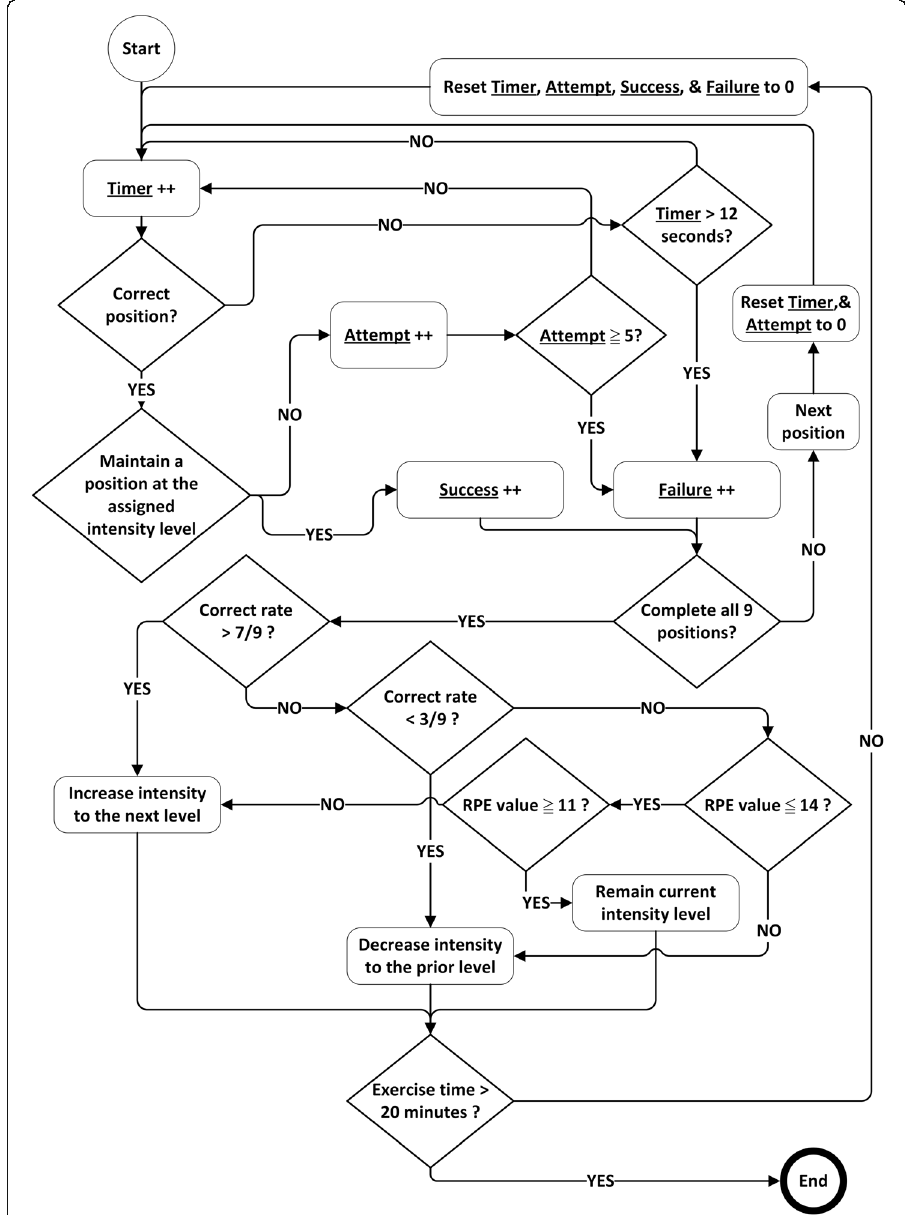
Fig. 3 The flowchart of the dual adaptive strategy (MCR &